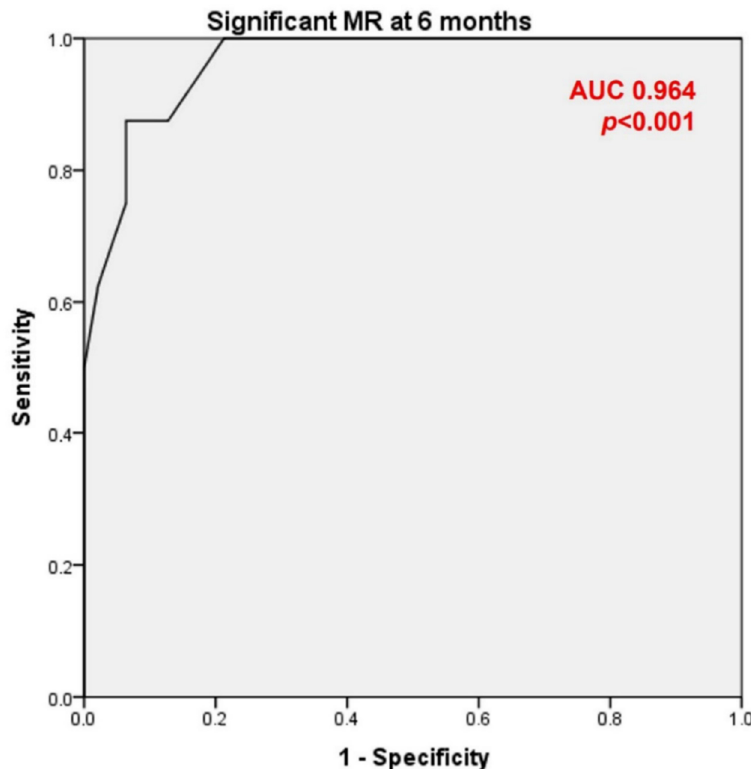
Figure 3. ROC curve of maximum VC for prediction of significant MR at 6 months. ROC: